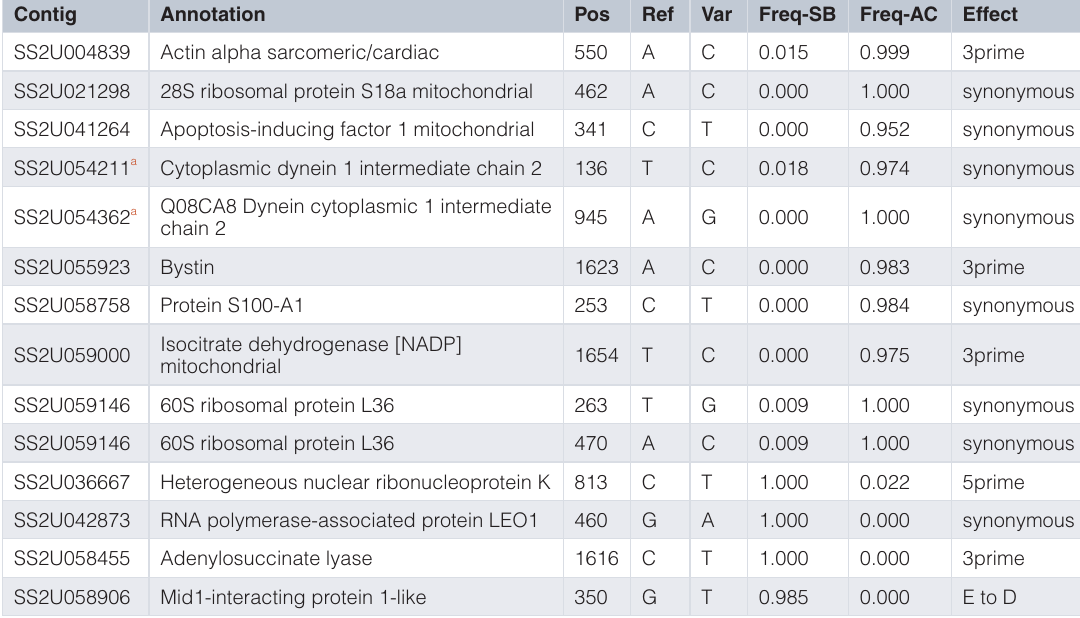
Table 6. SNP candidates with significant difference frequency between AC and SB morphs, from reads that mapped to two or more contigs.